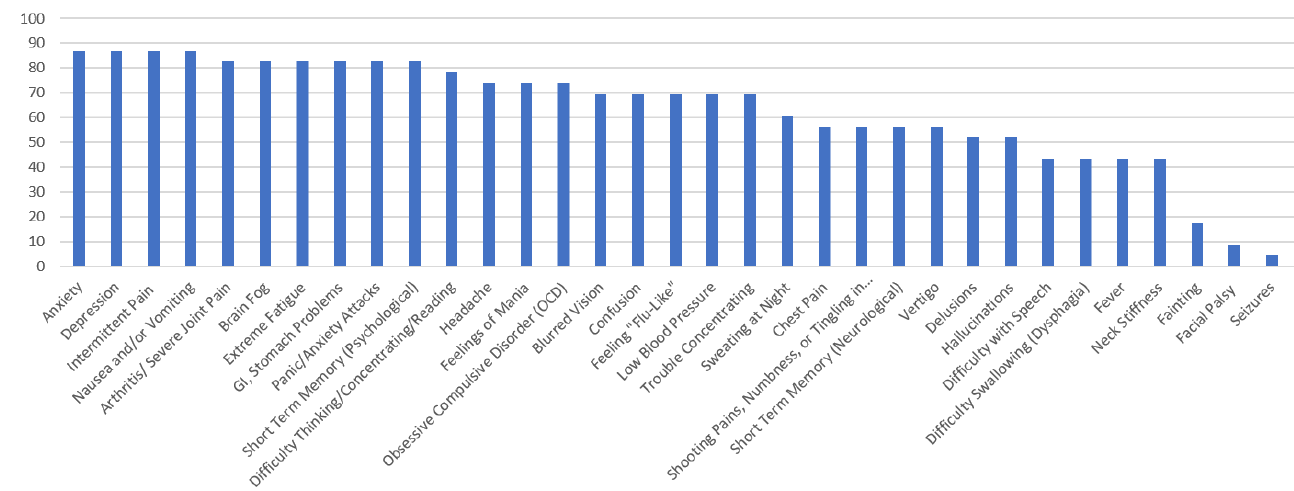
Figure 1. Percentage of Respondents with Ehrlichiosis Reporting Specific Symptoms.